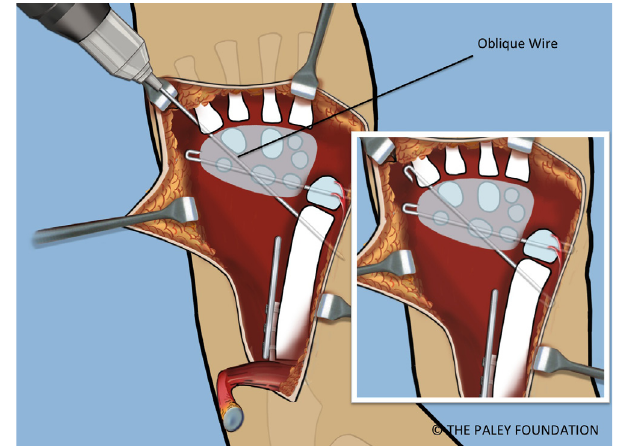
Figure 16. The distal ulna is stripped of some of its periosteum to allow the ulna to shorten and overlap the proximal end. Shortening of the ulna allows it to migrate proximally relative to the carpus. The ulnar head should sit opposite the scaphoid. This is referred to at station.